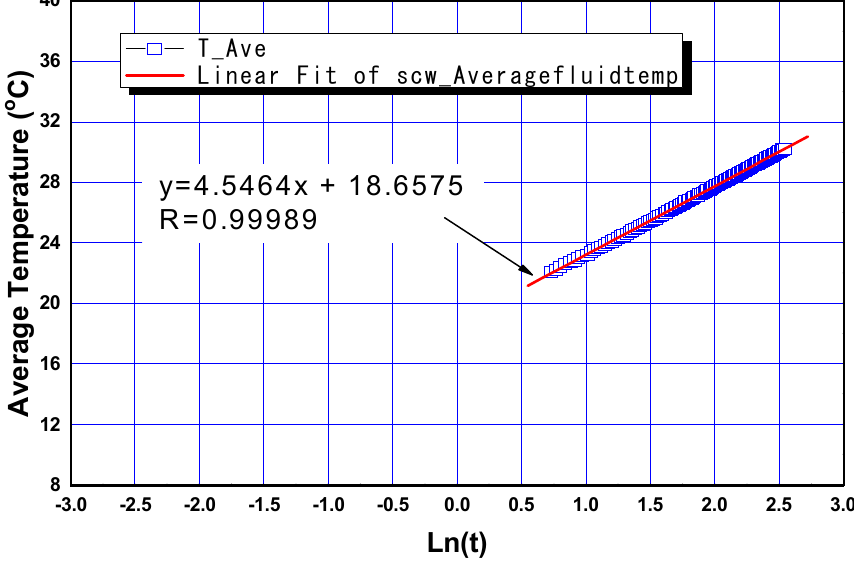
Figure 9. Linearization of the average temperature at the location of the upper return pipe. Table 6. Results of effective conductivity calculation.